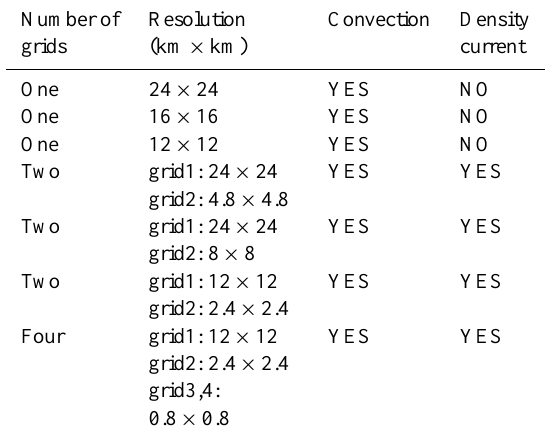
Fig. 13. Time evolution of dust concentration (µgm − 3 ) over Tinfou station on 31 May 2006. Table 1. Summary of sensitivity tests for seven model configura-